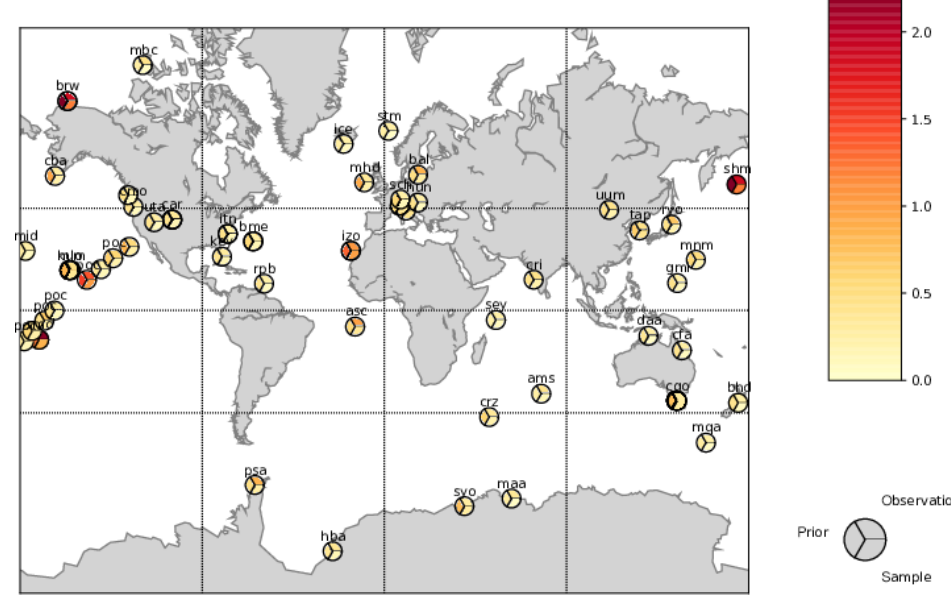
Figure 3. Assumed standard deviations, standard deviations taken from the diagonal of R prior and R sample for a representative subset of